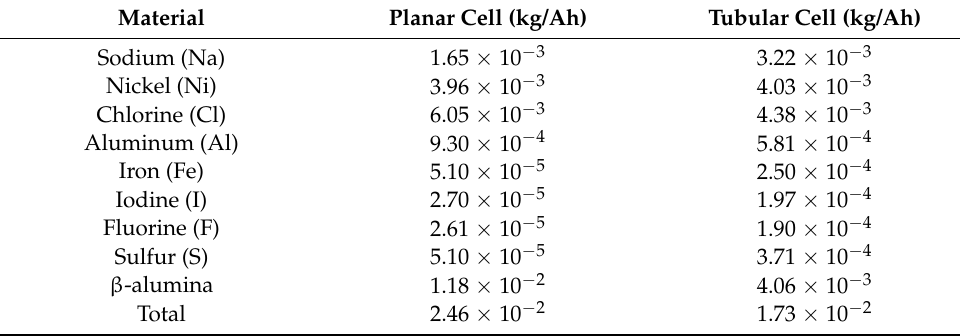
Table 2. Materials used for the cell manufacturing (data refer to 1 Ah of cell capacity).